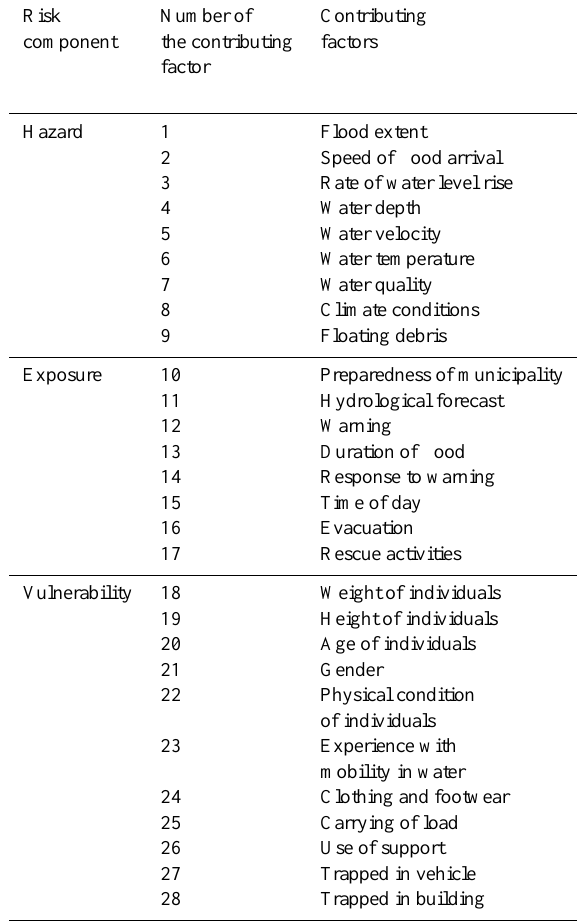
Table 2. Summary of contributing factors influencing loss of life during